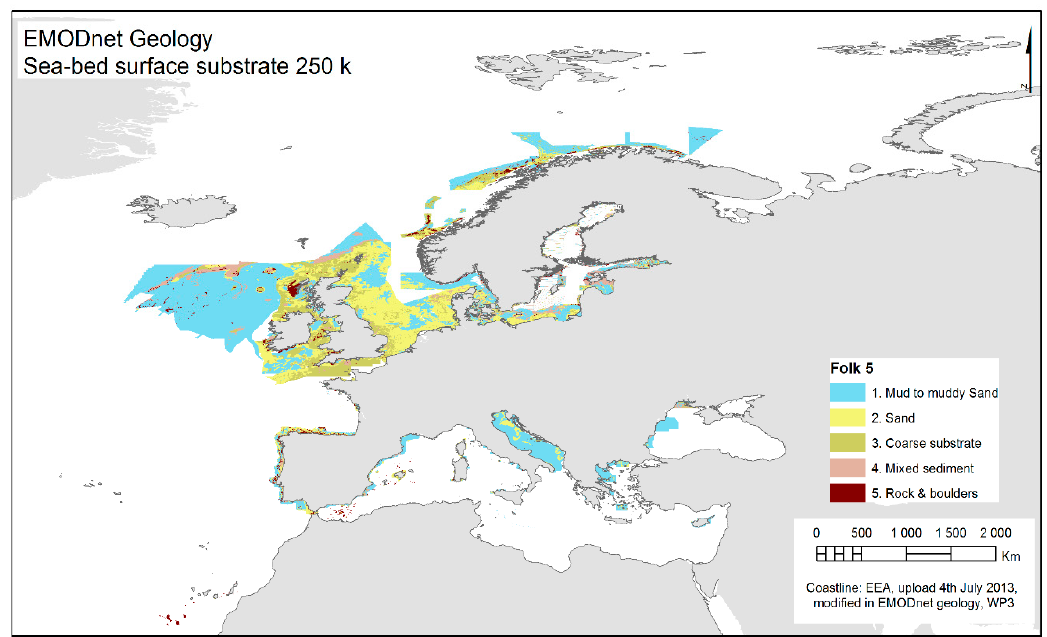
Figure 6. EMODnet Geology seabed surface substrate data at a scale of 1:250,000 (250 k) for the European seas, hierarchy of five Folk classes.